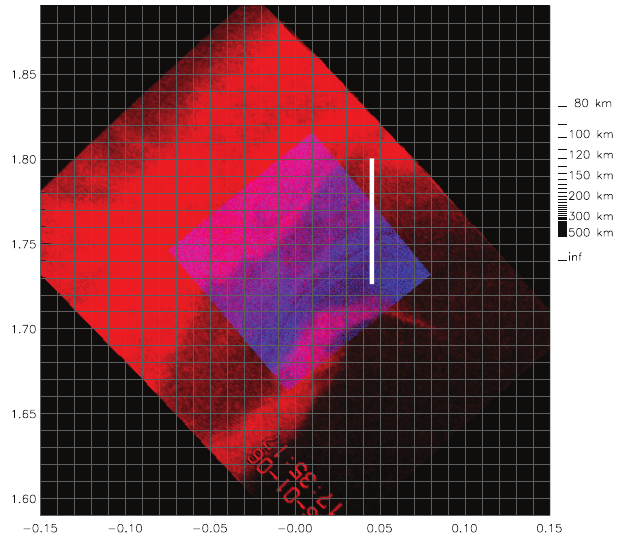
Fig. 8. ASK image (blue) plotted on top of SIF image (red), to illustrate the difference in field of view, and the parallax (white line) caused by the 7km distance between the imagers. The grid step is 0.01 rad.